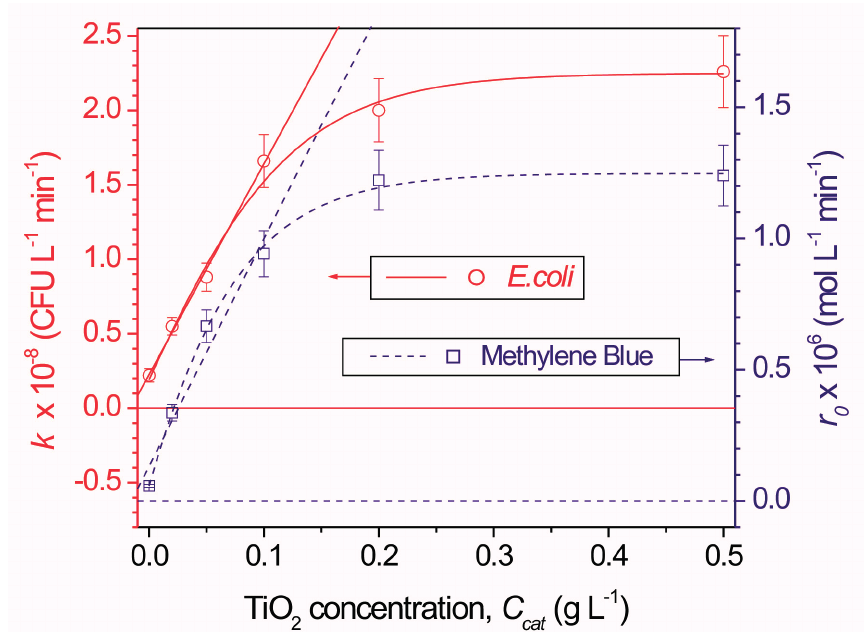
Figure 2. Kinetic constant for E. coli inactivation and initial reaction rate of methylene blue oxidation as a function of TiO 2 concentration. Reproduced from [39] with permission from